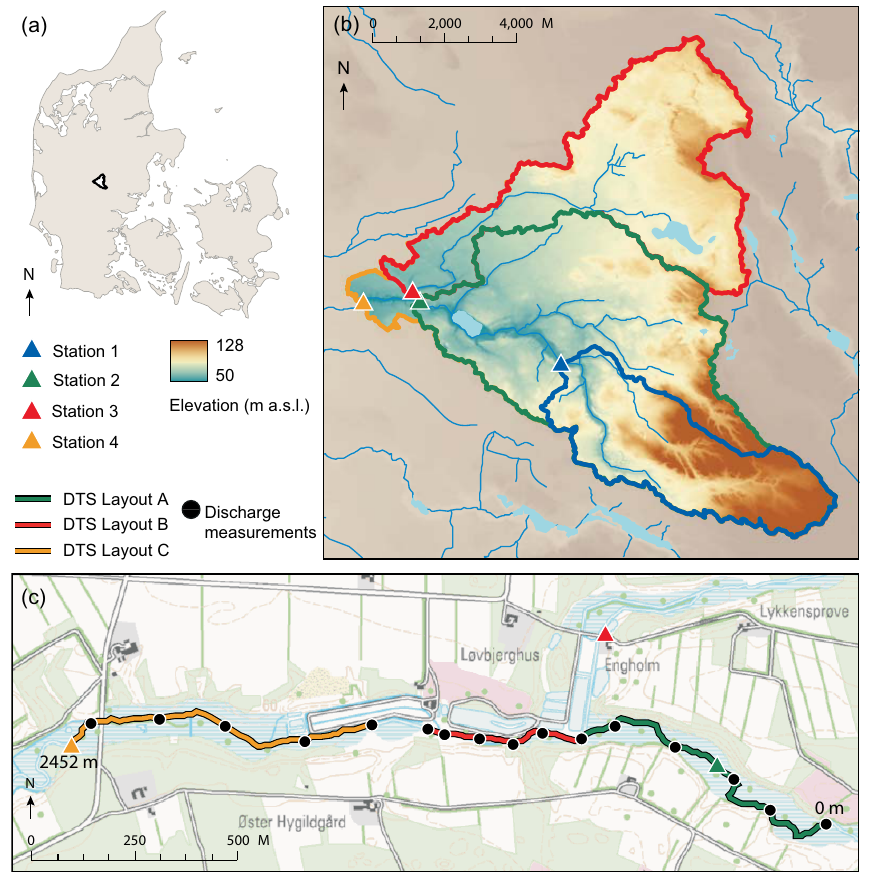
Figure 1. Map of the study area and sampling sites. (a) Map of the study area in Jutland, Denmark, showing the Skjern River catchment and sampling sites. At this site, the stream flows from east to west. (b) Locations of the stations of event samplings and their corresponding catchments. (c) The campaign measurements conducted between station 2 and station